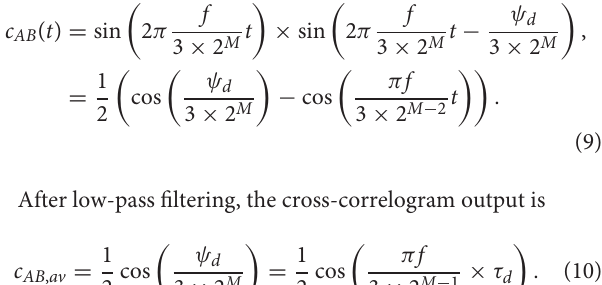
Frontiers in Neuroscience |